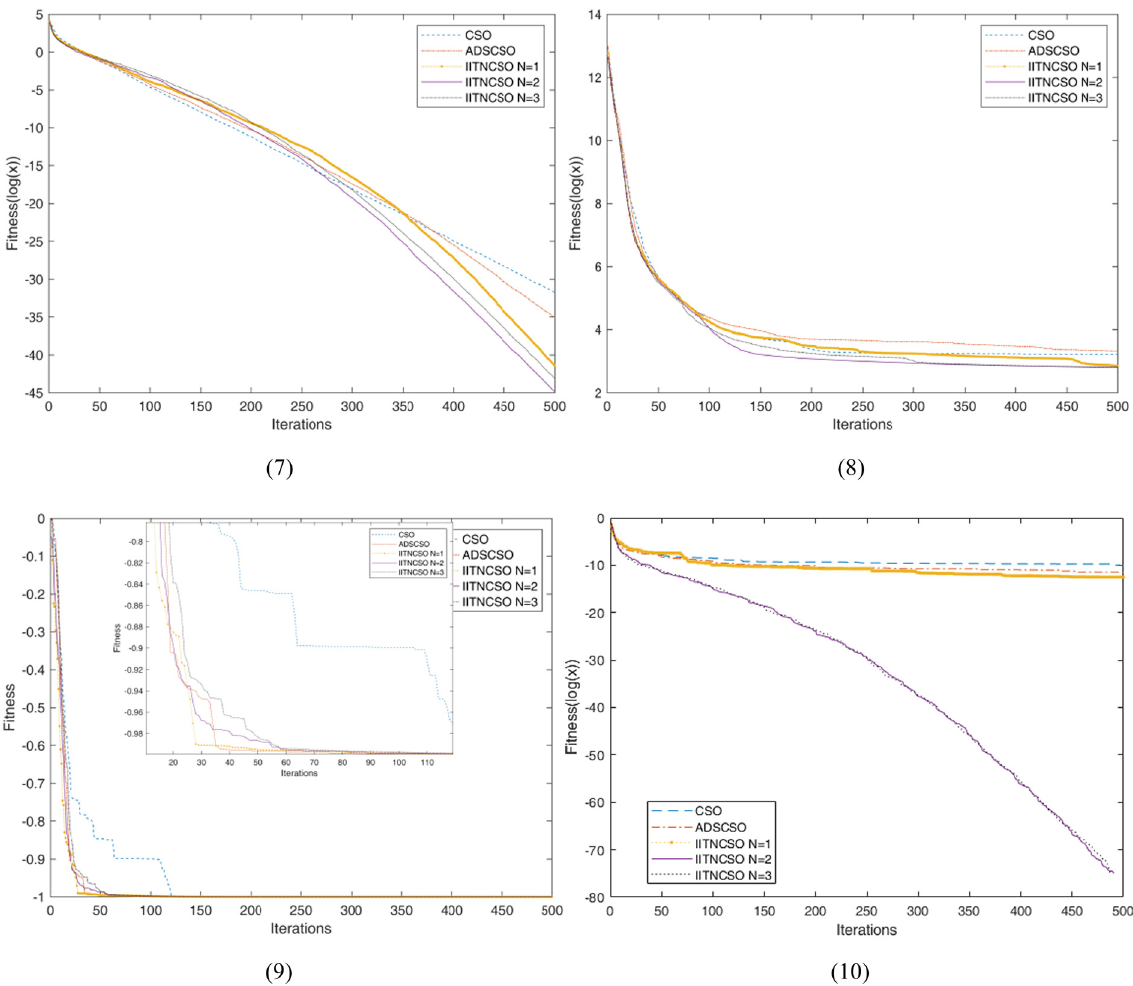
Figure 2: Comparisons of fi tness change of F1 – F10: ( 1 ) F1, ( 2 ) F2, ( 3 ) F3, ( 4 ) F4, ( 5 ) F5, ( 6 ) F6, ( 7 ) F7, ( 8 ) F8, ( 9 ) F9, and ( 10 )